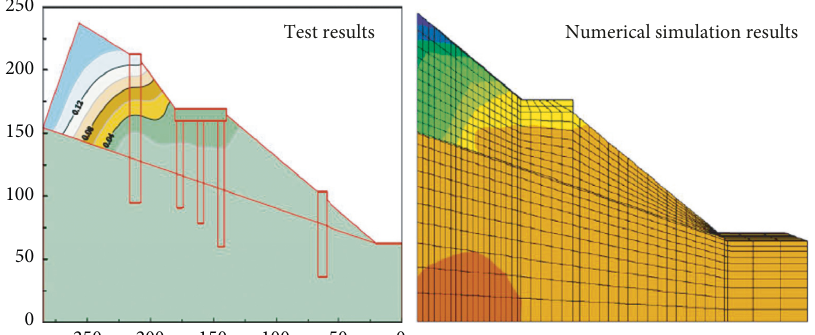
Figure 25: Comparison of the horizontal displacement field of the front and rear antisliding piles reinforced with the antisliding section of the bridge foundation and the model test.